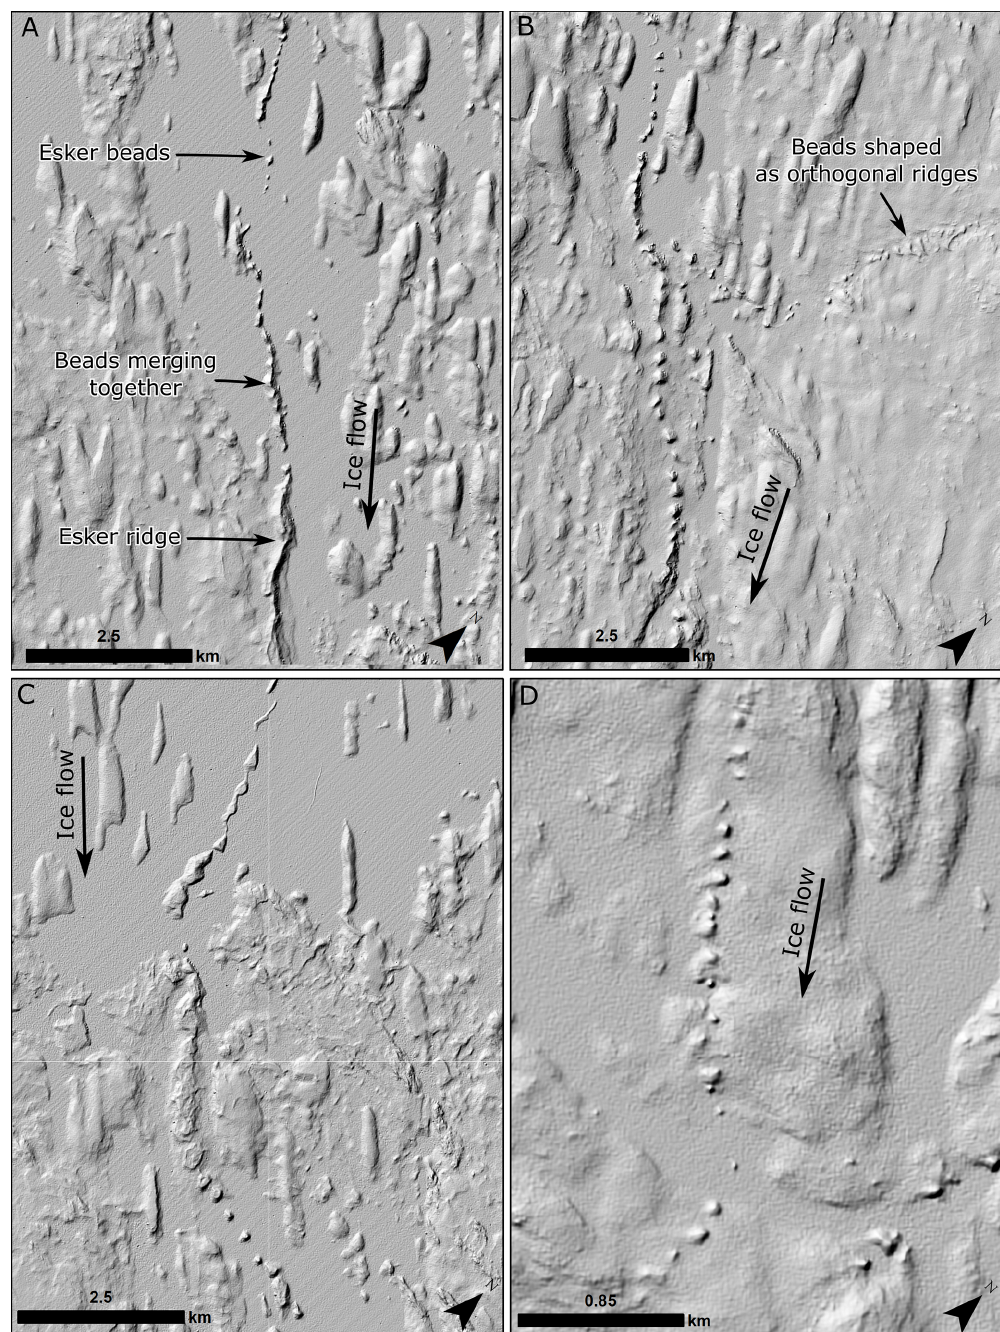
Figure 3. Examples of beaded eskers. (a) Transition between a classical esker ridge and esker beads, some of which merge together to form a ridge-like form due to their large size and/or close spacing. Note how the beads range in shape from ridge-like to (b) triangular (c) , flat-topped (c) , and circular (d) . Hill-shaded ArcticDEM has 2m horizontal resolution. Locations of beaded eskers displayed in Fig. 1. DEMs created by the Polar Geospatial Center from DigitalGlobe, Inc.,